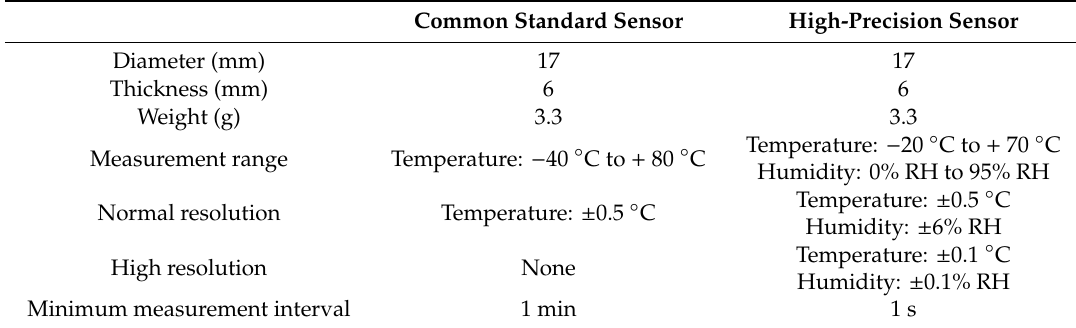
Table 6. Sensor measurement results in winter.